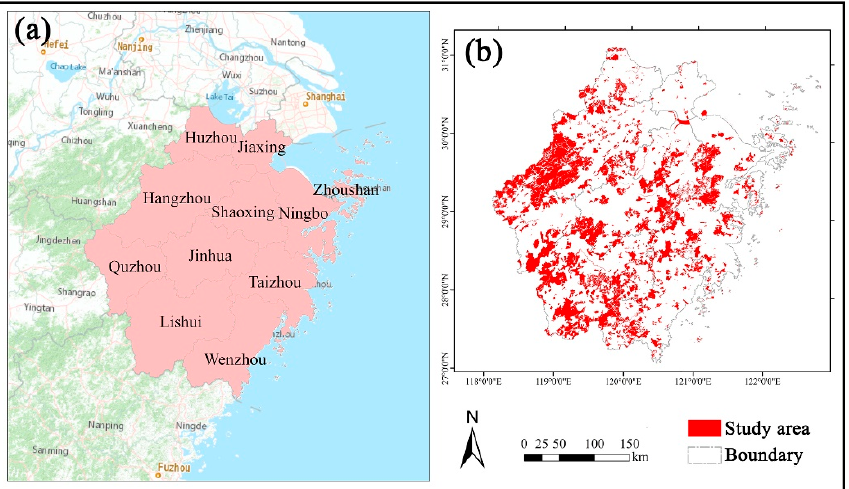
Figure 1. ( a ) Location of Zhejiang Province; ( b ) The land area within ECR in